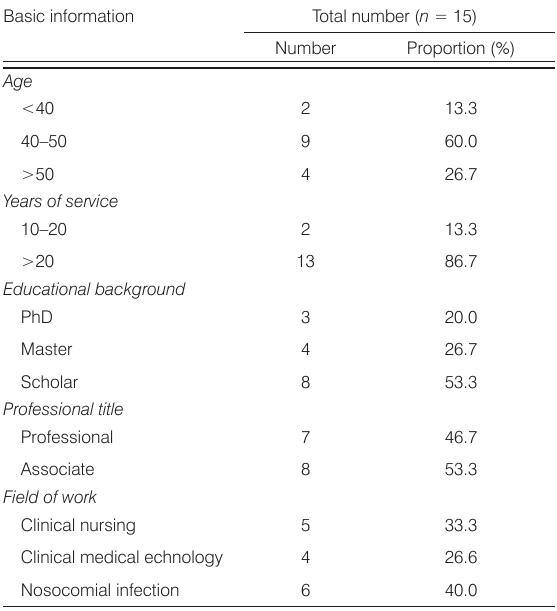
Table 1. Experts’ sociodemographic information.